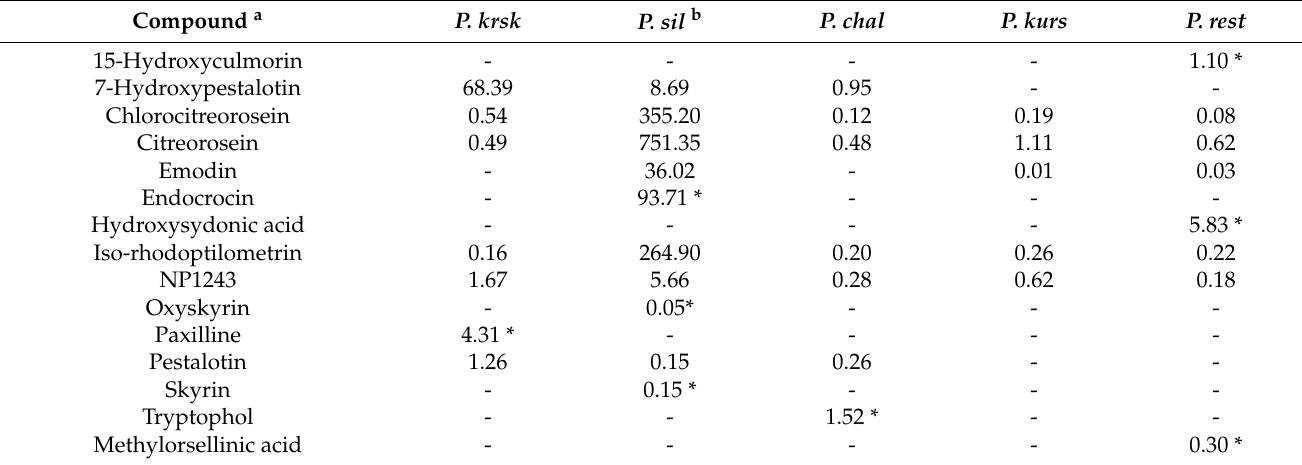
Table 5. Metabolite profile of five phylogenetically close Penicillium species (ex-type cultures) in series Restricta growing on yeast extract medium (YES) for 14 days at 25 ◦ C and in the dark, after extraction with acetonitrile/water/acetic acid (79:20:1) and being measured by LC–MS/MS (concentration in µ g.g − 1 ). Compound